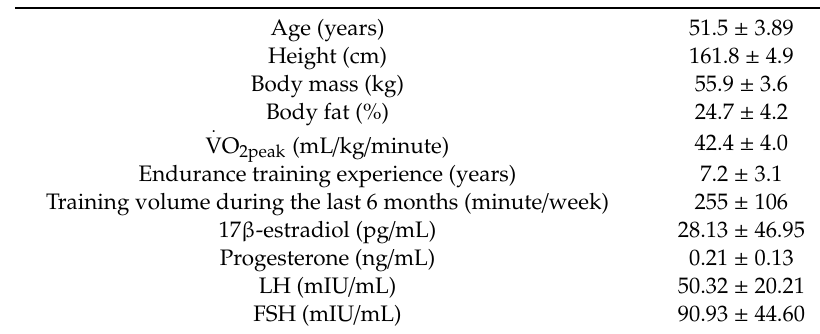
Table 1. Participants’ characteristics and sex hormones concentrations at baseline. Data presented as mean ±